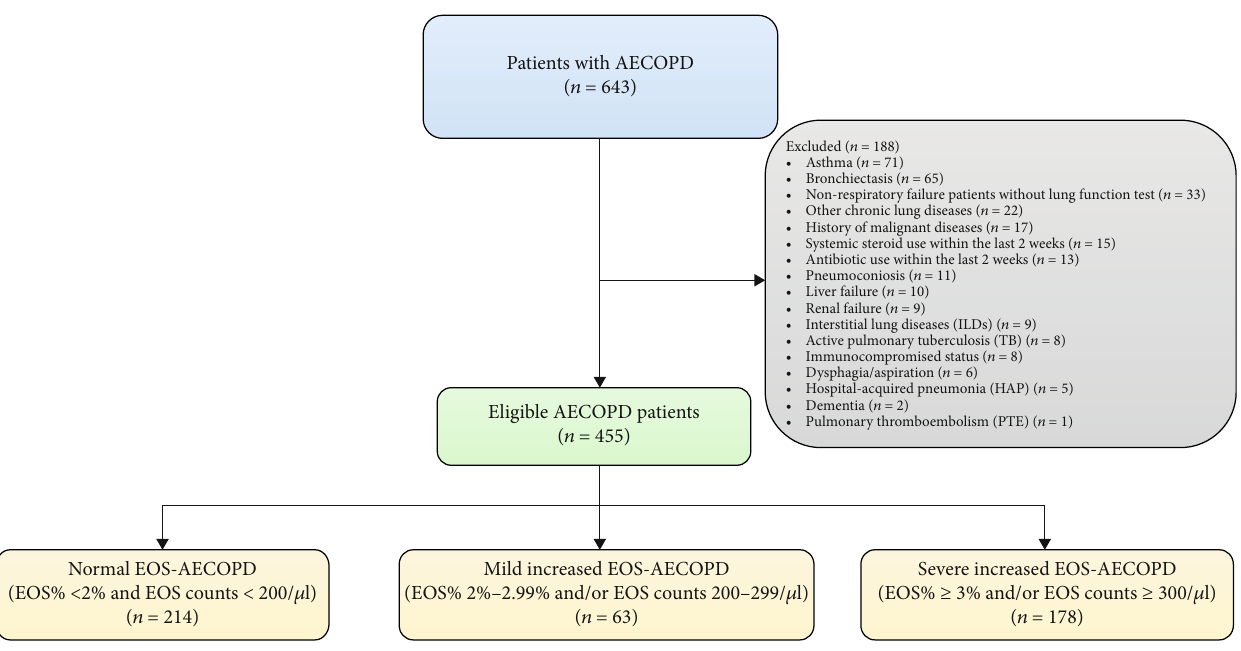
Figure 1: Flow diagram of the